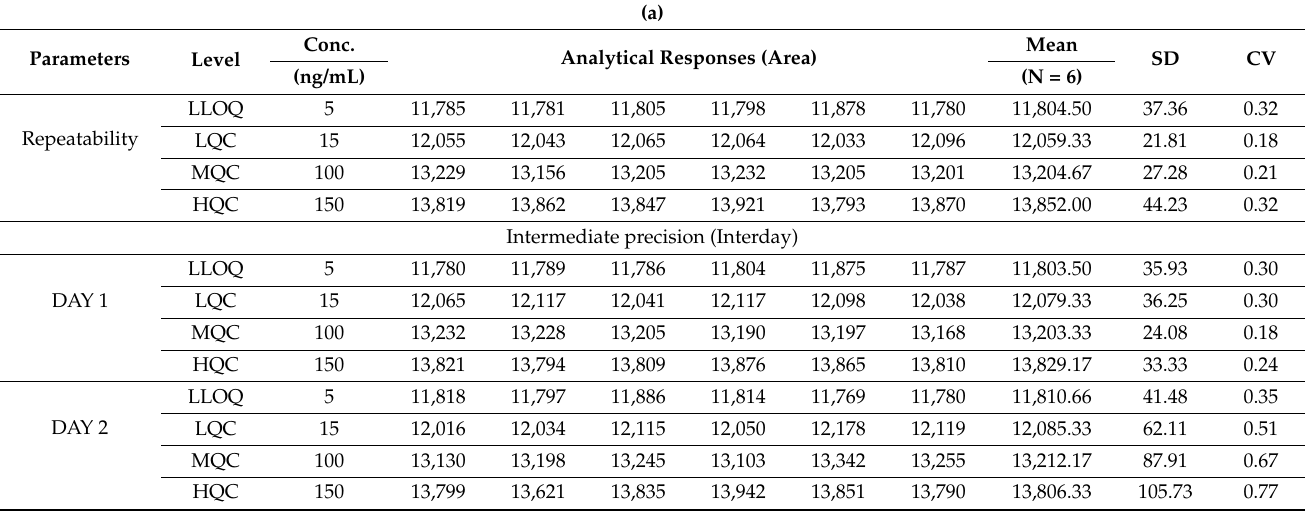
Table 2. ( a ) Results of precision studies for CIN. ( b ) Results of precision studies for DOM.